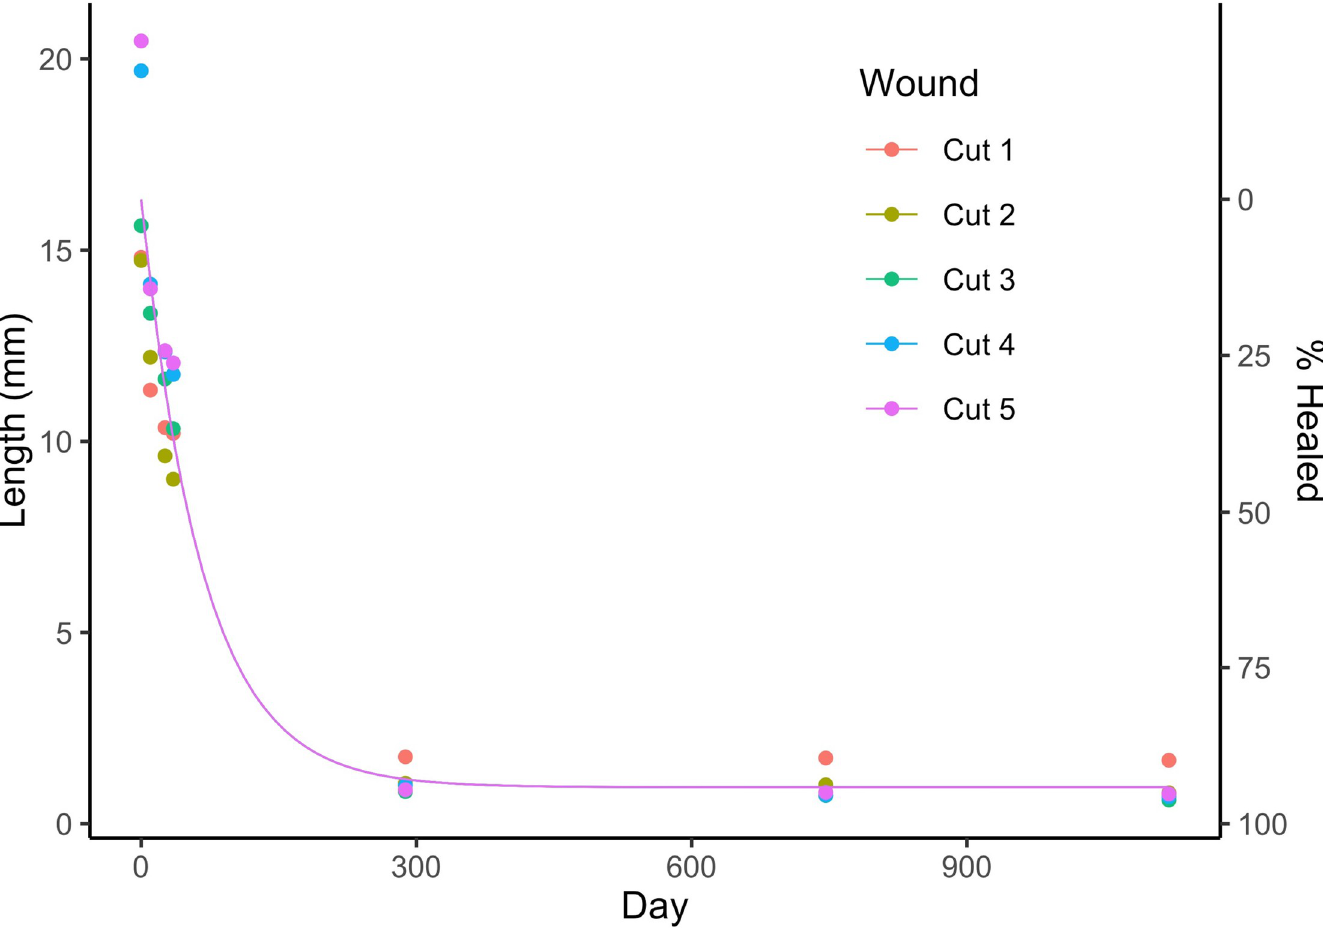
Fig 3. Wound healing rates from reef manta ray Mobula alfredi #0018. The wound length (mm) and percentage of wound healed over time, with Day 0 representing the first observation of the animal with fresh (severed cartilage and red tissue) wounds. A negative exponential model was fit to the data (y = 15.4e -0.0149x + 0.956, pseudo-r 2 = 0.96).